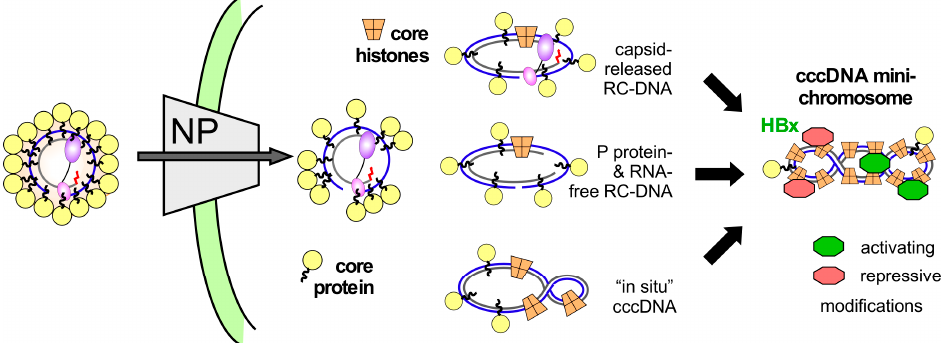
Figure 2. A speculative model for HBV cccDNA minichromosome formation. Interactions at the nuclear pore (NP) cause disintegration of the nucleocapsid structure [18]; however, due to the core protein’s nucleic acid binding C-terminal domain (CTD) (wiggly lines emanating from the yellow spheres symbolizing core protein) not all core protein subunits may be immediately stripped from the RC-DNA. Loading with histones could thus initiate on complexes with still bound P protein and largely unprocessed RC-DNA, or any time later when P protein is released and one or both DNA strands are freshly ligated (termed “in situ” cccDNA in Figure 2). While eventually most molecules will be covalently closed and fully chromatinized, activating and repressive modifications (symbolized by the green and red objects), modulatable by HBx, may be added before this state is reached. In reality, it is likely that on a single cccDNA minichrosome either activating or repressive marks dominate.